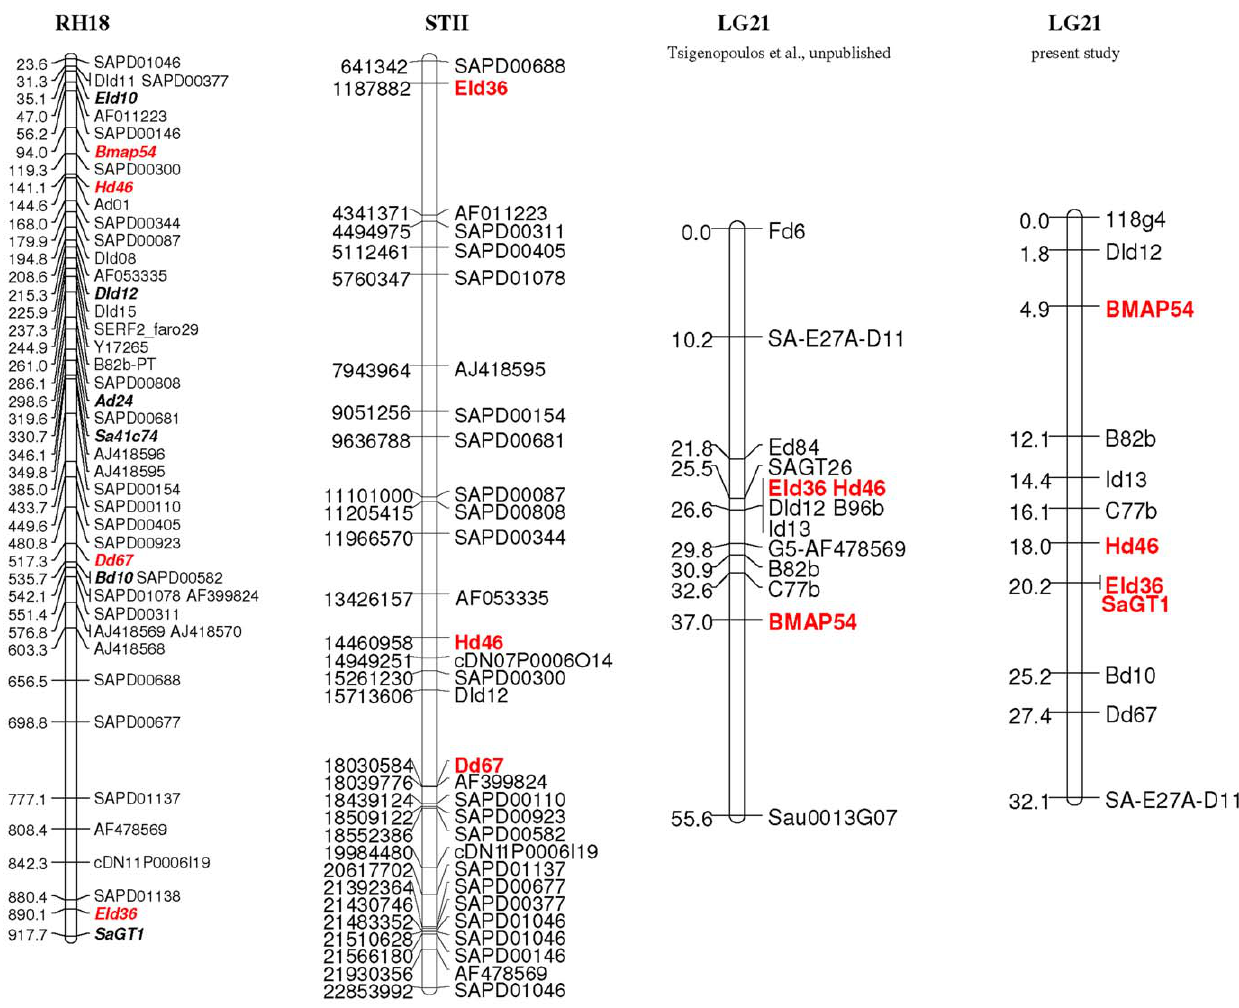
Figure 1. Radiation hybrid group 18 in comparison to linkage group 21. Sparus aurata radiation hybrid group 18 (RH18, [20]), genetic linkage group 21 (LG21) and homologues found in three-spined stickleback ( Gasterosteus aculeatus ) chromosome STII. Highlighted in bold red are the candidate microsatellite markers linked to growth and sex. Highlighted in bold are the genotyped markers for the QTL analysis.